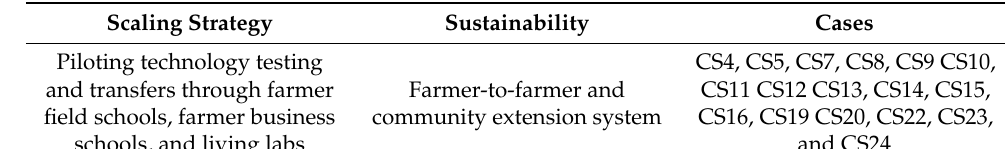
Table 4. Scaling and sustainability of the process in